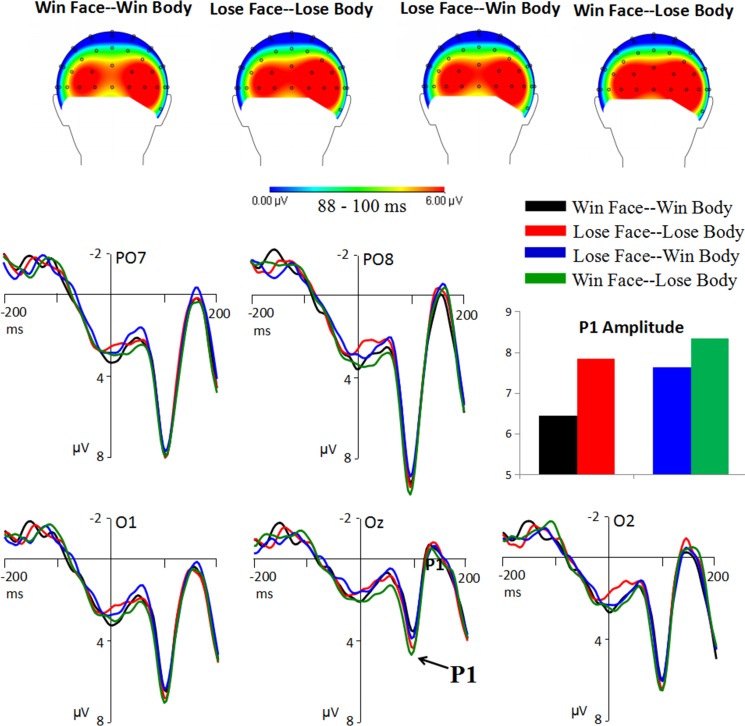
Grand average of the P1 component.Please note that the topographic maps did not show the distribution of voltage over the left mastoid (i.e. the reference electrode).